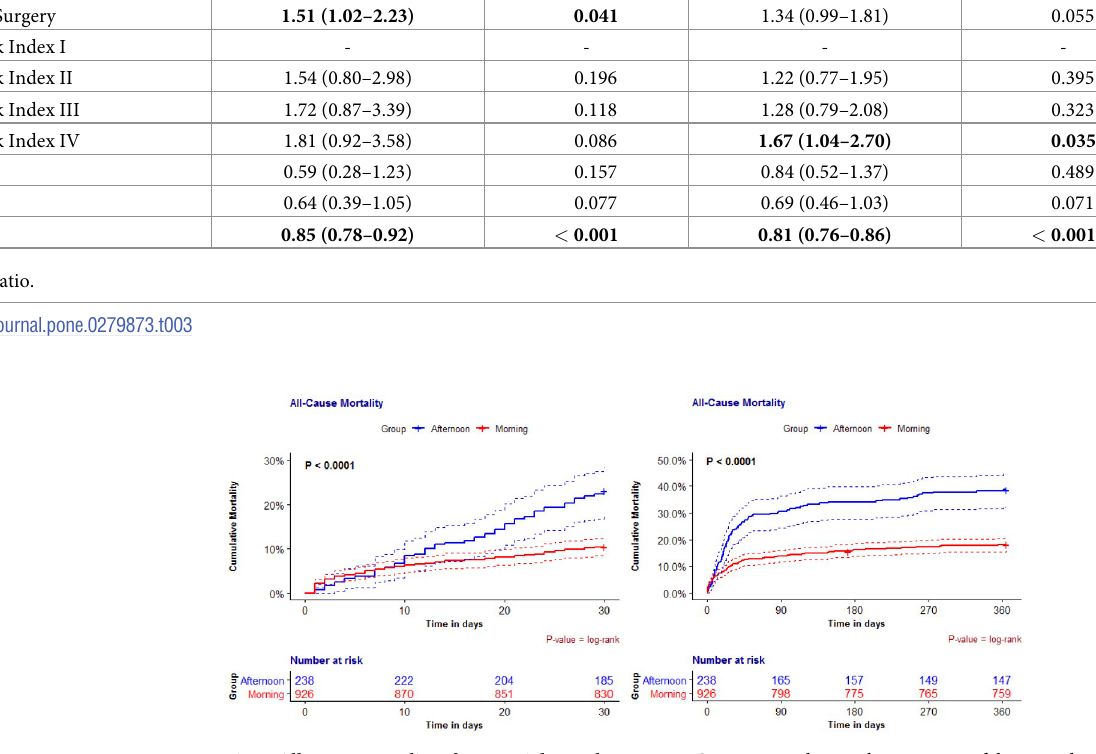
Fig 1. All-cause mortality after arterial vascular surgery. Groups according to the start time of the procedure in the cohort population in 30 days (A) and one-year (B) follow-up.